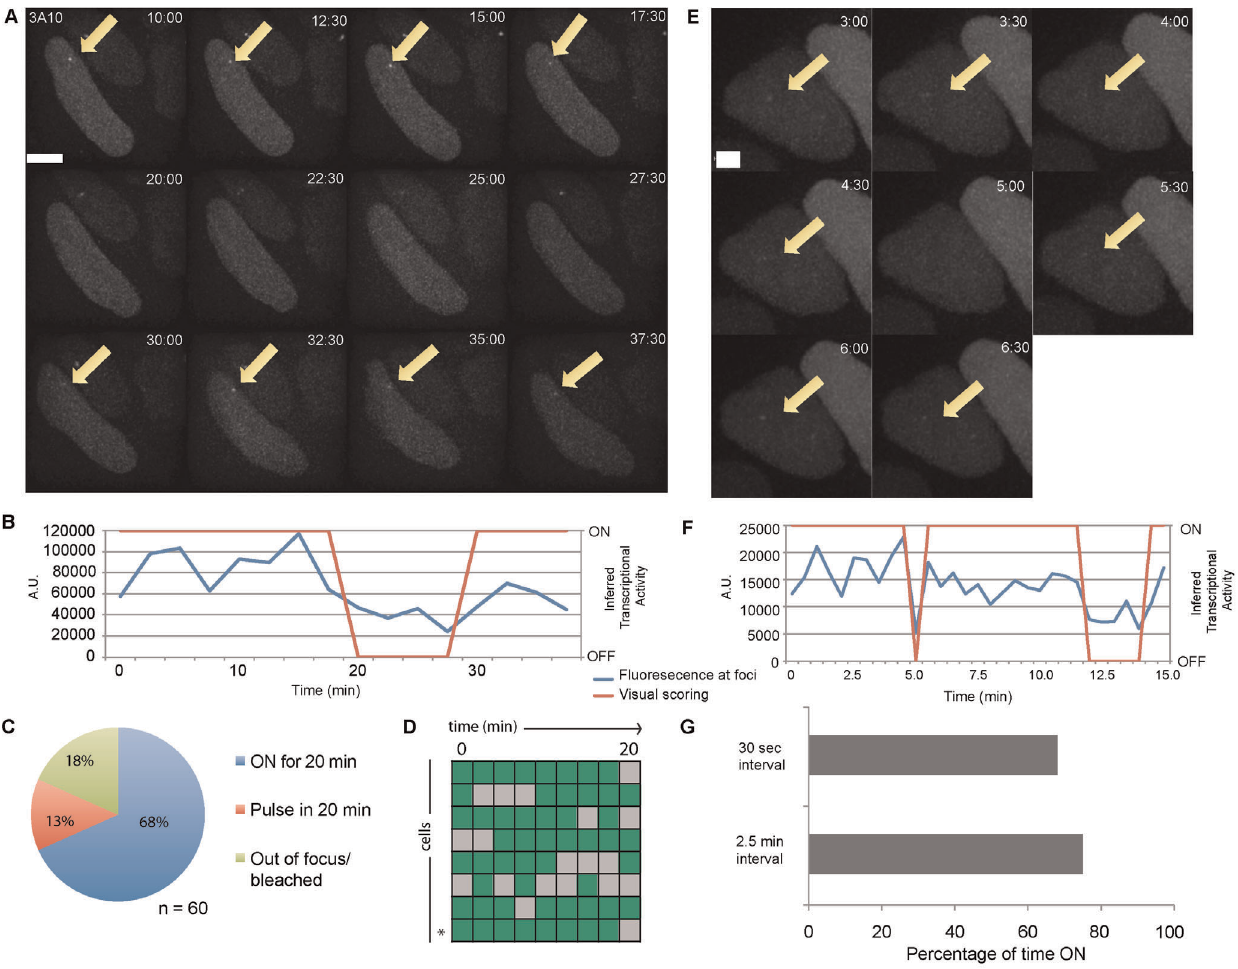
Figure 4. Transcription dynamics of Clone 3A10. A. Representative detection of transcriptional pulses in one cell from Clone 3A10 at 2.5 minute intervals. Transcription foci indicated by arrows. Scale bar=2.5 m M. B. Transcription foci of the cell depicted in Figure 4A was quantified for EGFP intensity over time. EGFP intensity plots were determined by subtracting background fluorescence at each time point (Blue line). Red line represents visual scoring of inferred transcriptional activity. C. Transcriptional activity of cells possessing EGFP foci at the start of live imaging. D. Summary of transcriptional dynamics displayed by all pulsing cells in Clone 3A10. Green squares indicate timepoints with detectable transcription foci and gray squares represent timepoints without transcription foci. Each square represents 2.5 minutes. The cell shown in Figure 4A is denoted with an asterisk. E. Representative image of transcriptional pulsing of a Clone 3A10 cell recorded at 30 sec intervals. Scale bar=2.5 m M. F. Intensity time series data (blue line) and visual scoring of inferred transcriptional activity (red line) on the pulsing cell depicted in Figure 4E. G. Cumulative periods of transcriptional activity recorded by the two image intervals. 60 cells were examined for 2.5 minutes interval and 12 cells were examined for 30 seconds